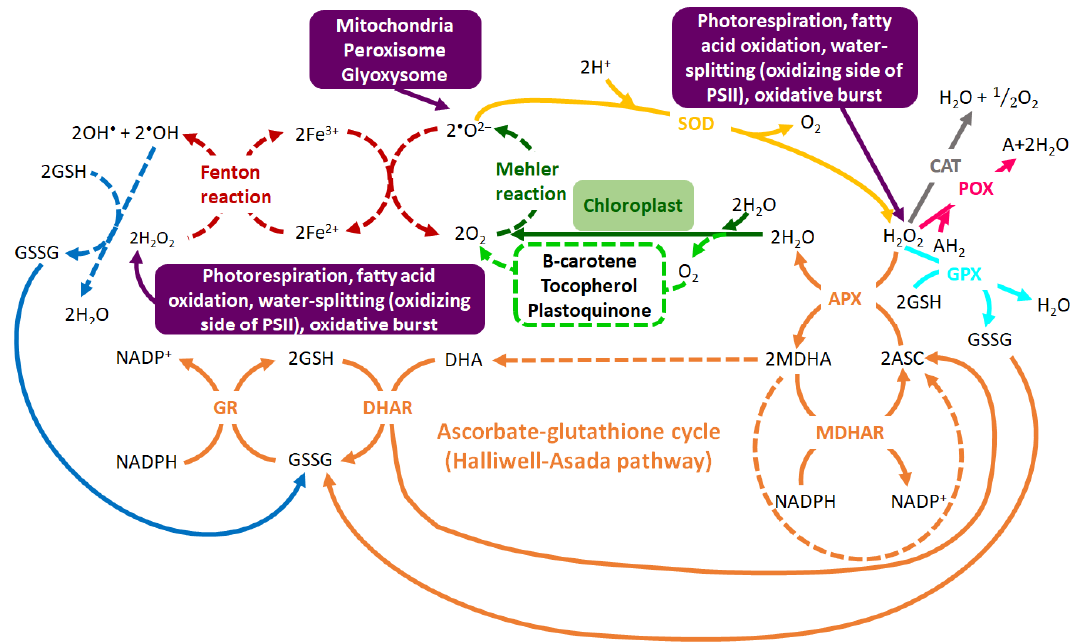
Figure 2. The intricate web of the highly-regulated oxidant-antioxidant system . Hydroxyl radical ( • OH) and superoxide anion radical ( • O 2 − ) are generated via the Fenton reaction (in red). • O 2 − is produced by Mehler reaction (in dark green) and singlet oxygen ( 1 O 2 ) from water molecules (in neon green). The initial step in the ROS scavenging is the conversion of • O 2 − into hydrogen peroxide (H 2 O 2 ) by superoxide dismutase SOD (in yellow), followed by the detoxification of H 2 O 2 by GPX (in turquoise), CAT (in grey), APX (in orange) and POX (in pink). H 2 O 2 is also scavenged through the ascorbate-glutathione cycle (in orange) which uses ASC and GSH as the cyclic transfer of reducing equivalents and NADPH as reducing power. The removal of • OH by GSH (in blue) forms GSSG which is regenerated to GSH via the GR-mediated reaction. The enzymatic pathways are depicted by bold lines and non-enzymatic pathways are indicated by dotted lines. Abbreviations: GPX = glutathione peroxidase, APX = ascorbate peroxidase, GR = glutathione reductase, ASC = ascorbate, MDHAR = monodehydroascorbate reductase, MDHA = monodehydroascorbate, AH 2 = oxidizable substrate, DHA = dehydroascorbate, DHAR = dehydroascorbate reductase, POX = non-specific peroxidase, GSH = reduced glutathione, GSSG = oxidized glutathione. Adapted from [54].